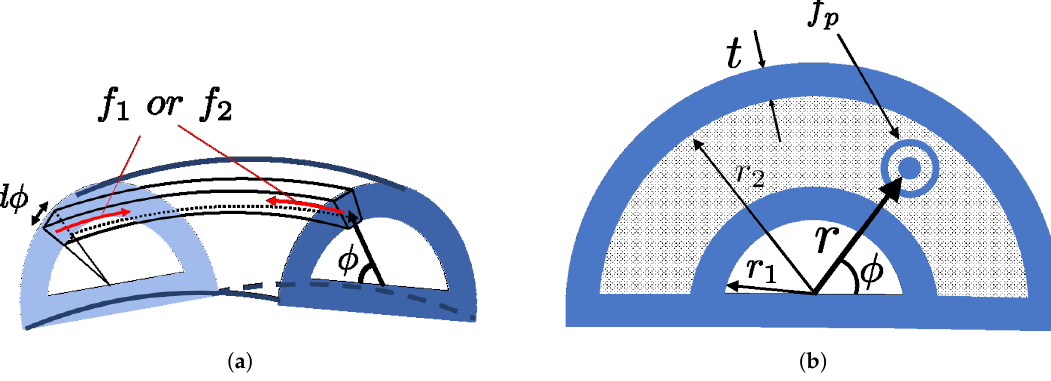
Figure 4. ( a ) f 1 working on a chamber or f 2 working on a channel; the chamber and the channel